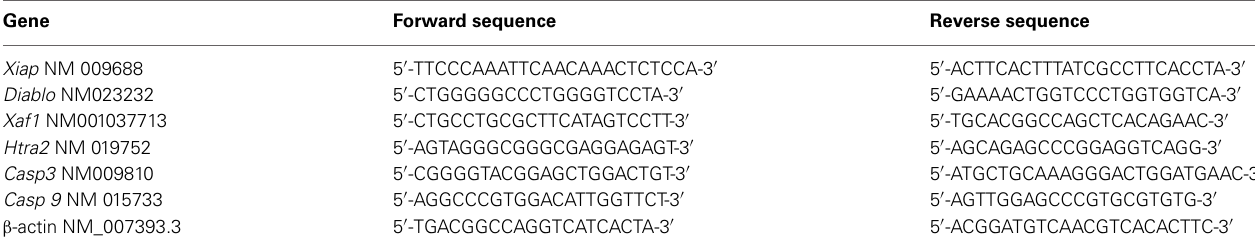
Table 1 | PCR primer sequences used in the experiments. Gene Forward